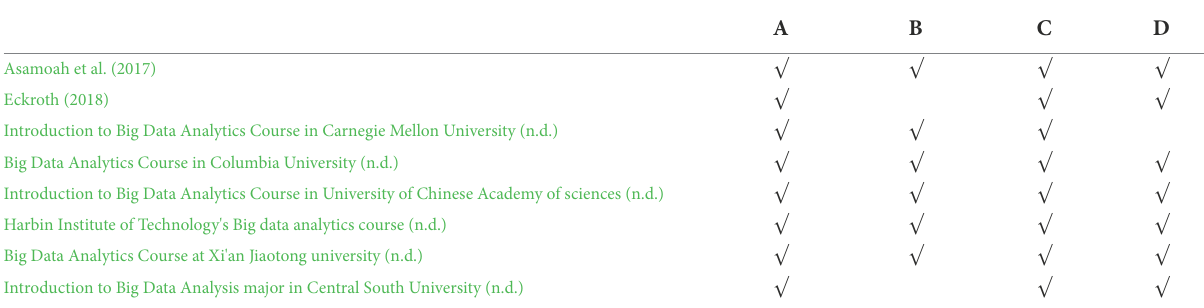
TABLE 2 Topics of big data analytics course.